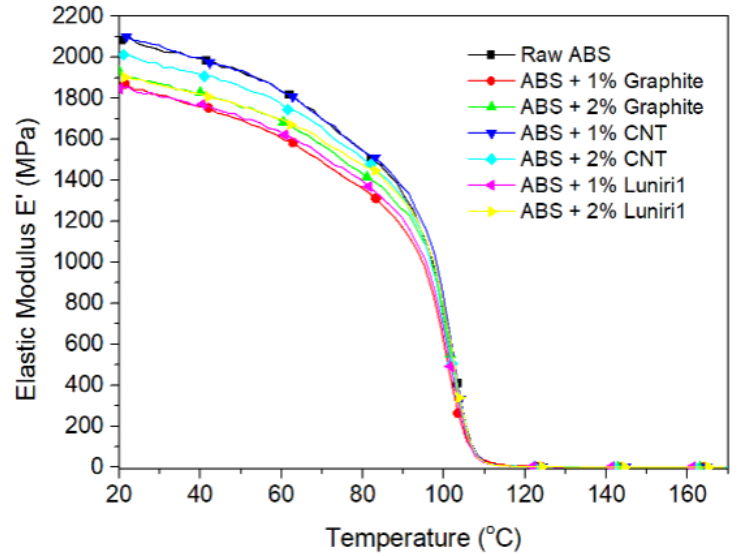
Figure 5. DMA result of PLA based filaments.